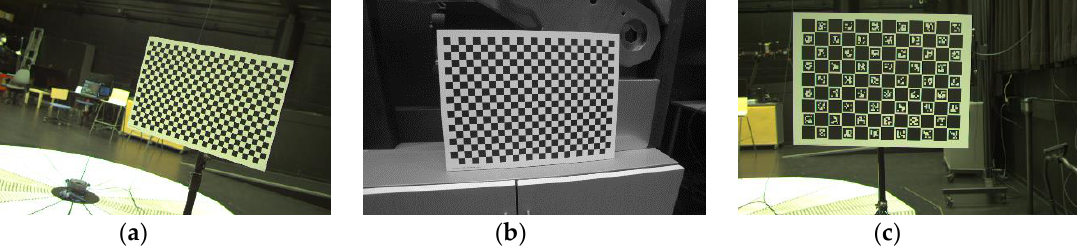
Figure 3. Example of captured images from the dataset 1 through 3; ( a ) checkerboard from dataset 1; ( b ) checkerboard from dataset 2; ( c ) ChArUco from dataset 3 .